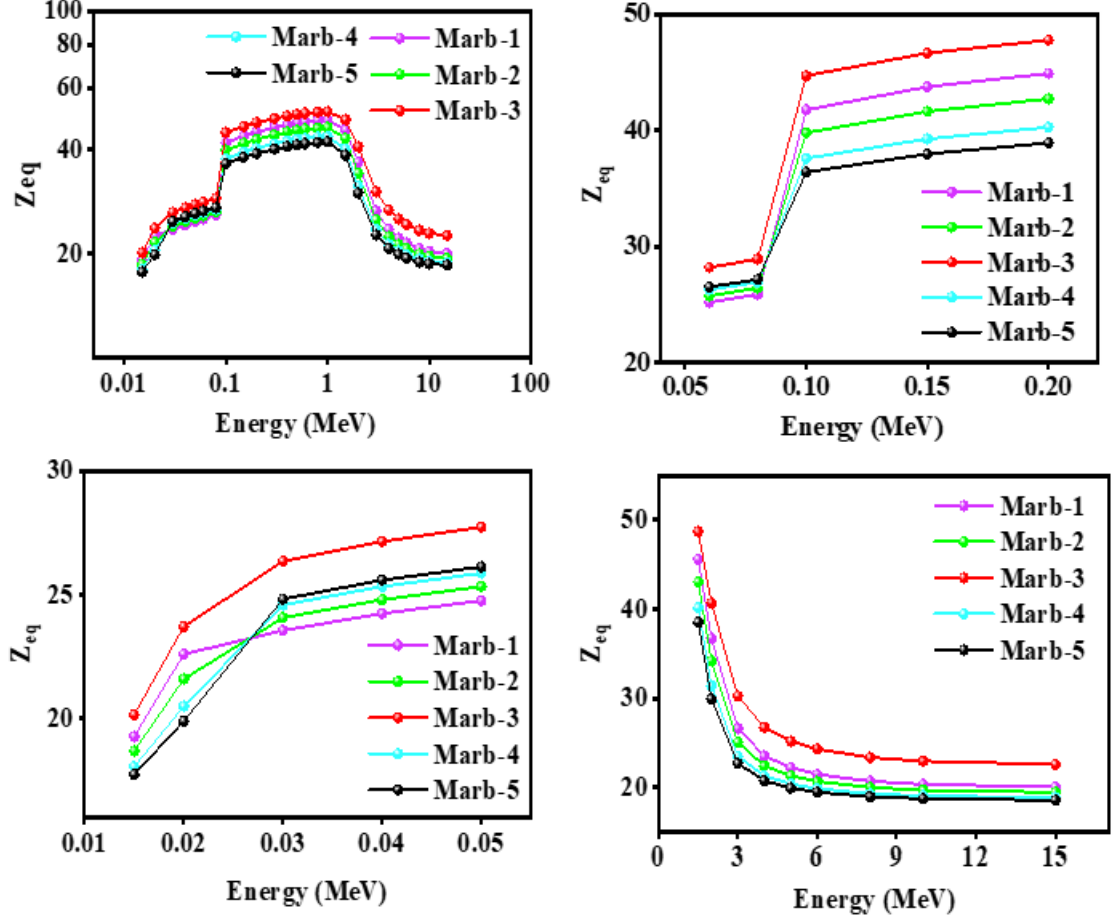
Figure 11. Illustration of the equivalent atomic number (Z eq ) of the prepared composites (waste marble/polyester/PbCO 3 /CdO) against incident photon energy.